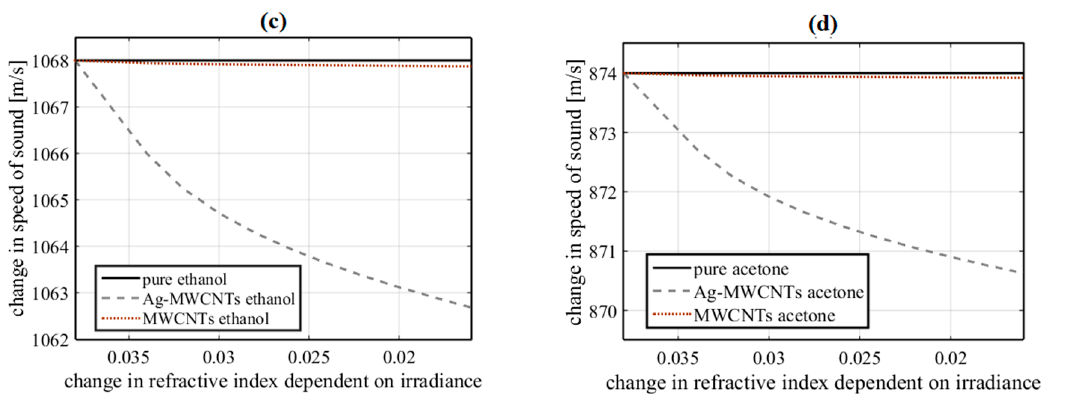
Figure 10. Numerical results of the induced change in compressibility modulus estimated by considering the experimental optical Kerr effect (OKE) in the nanofluids. ( a ) Ag-MWCNT samples, ( b ) MWCNT samples. ( c ) Change in the speed of sound due to Ag-MWCNT suspensions. ( d ) Change in the speed of sound due to MWCNT suspensions.